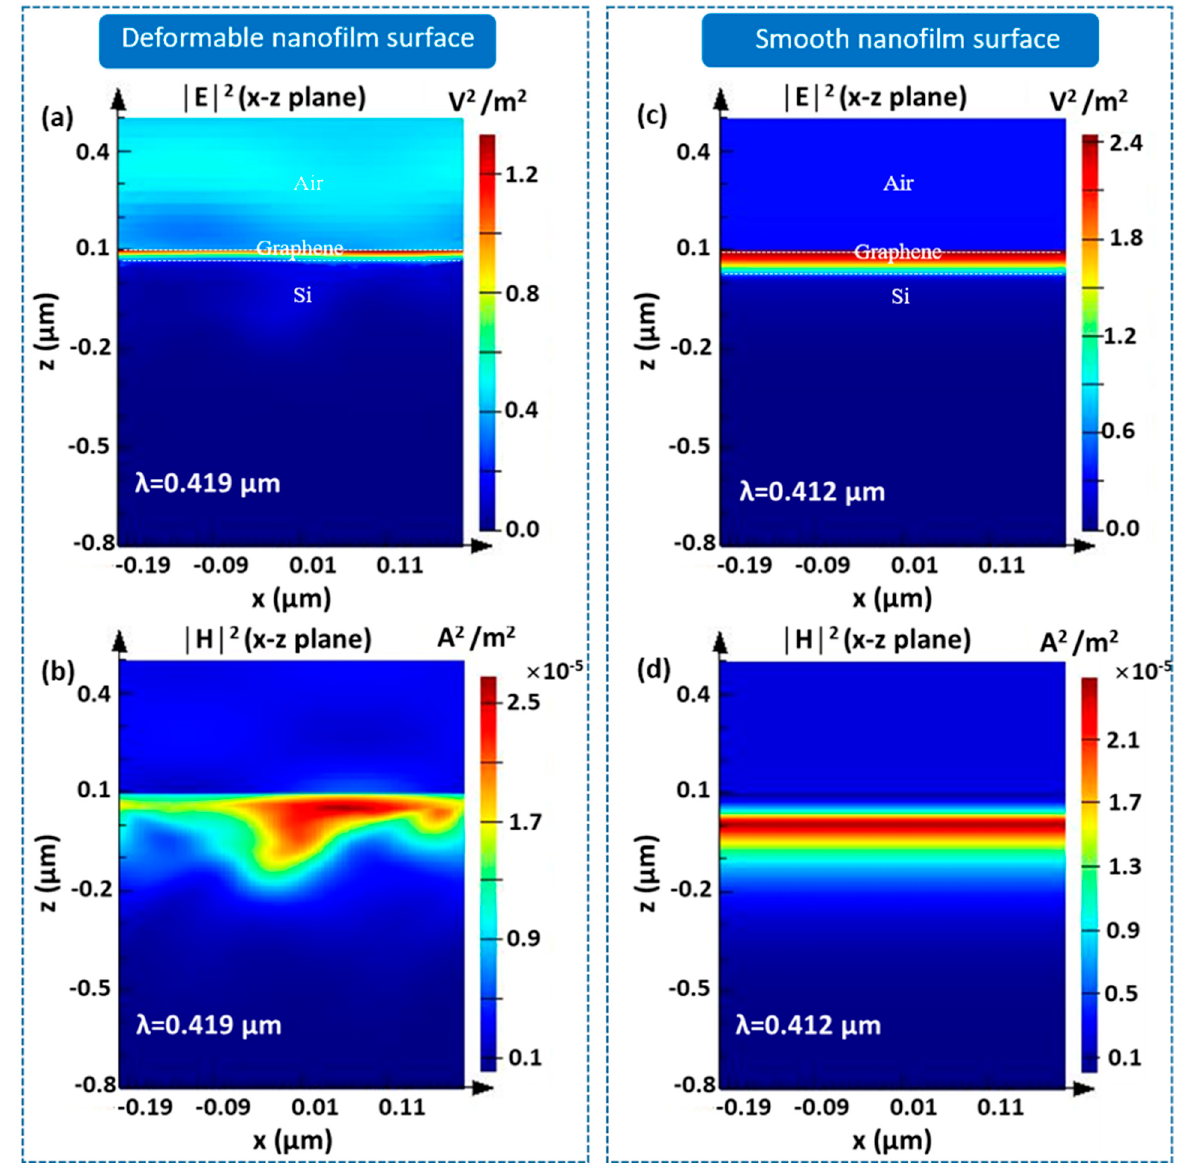
Figure 4. Simulated nearfield cross-sections at the resonance wavelength: electric field and magnetic field induced by ( a , b ) deformable and ( c , d ) smooth nanofilm surface structures, respectively.